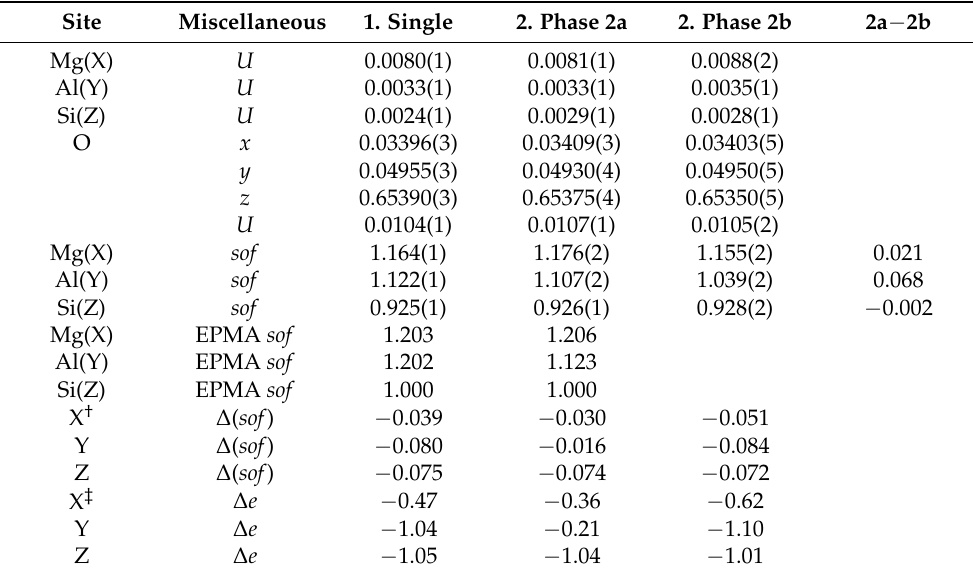
Table 3. Atom coordinates *, isotropic displacement parameters U (Å2), and sofs for two pyrope samples.